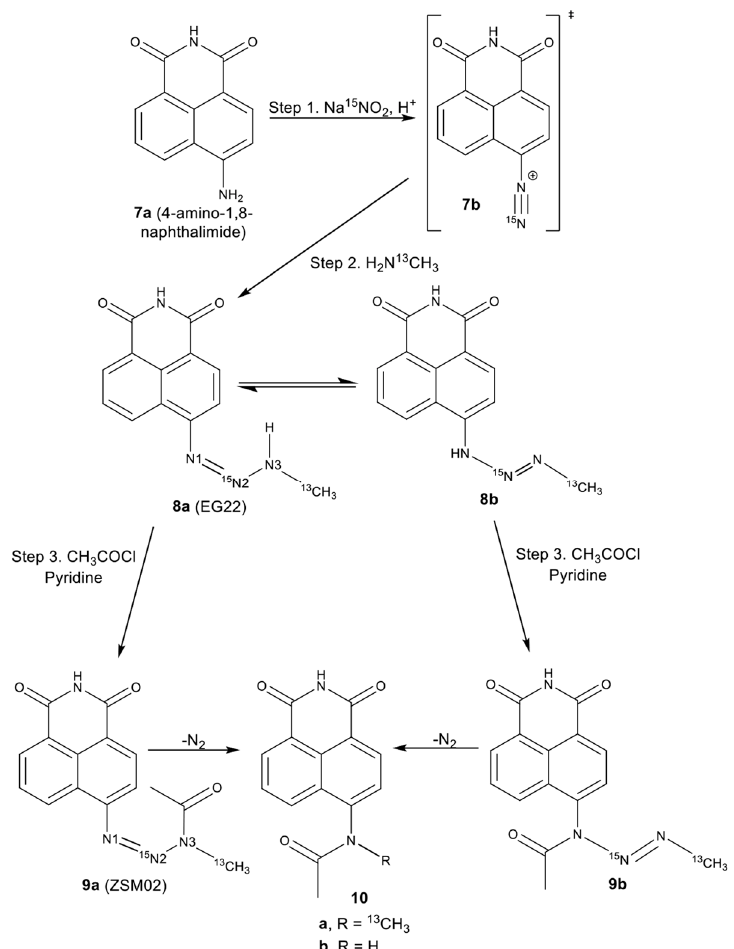
Scheme 2. Synthesis of ZSM02 ( 9a ) and possible